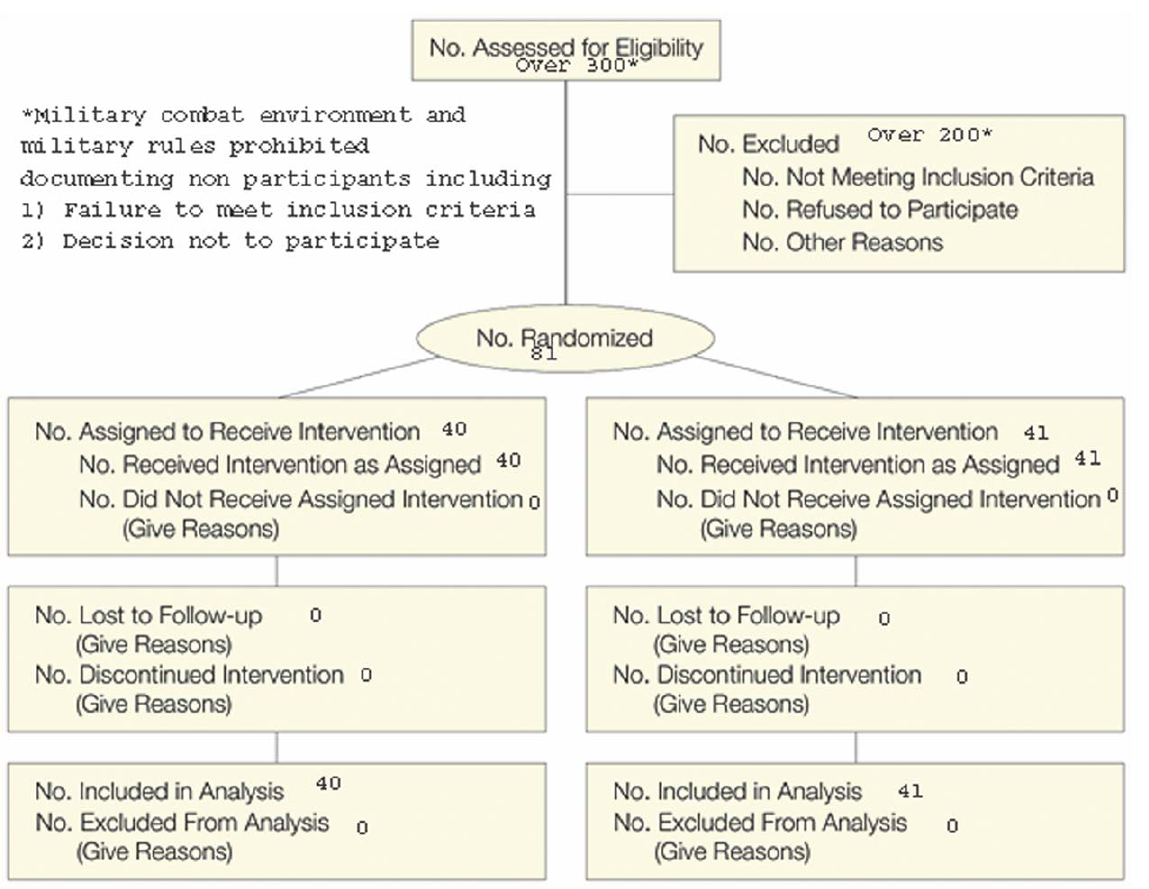
Figure 1. Consort Flow Diagram.